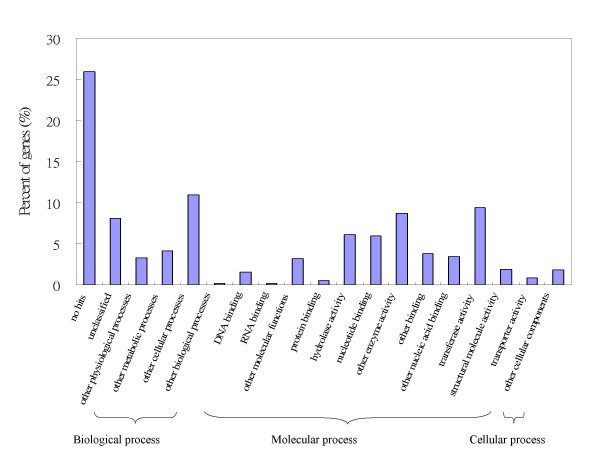
Functional classification of P. bellina flower bud dbEST.